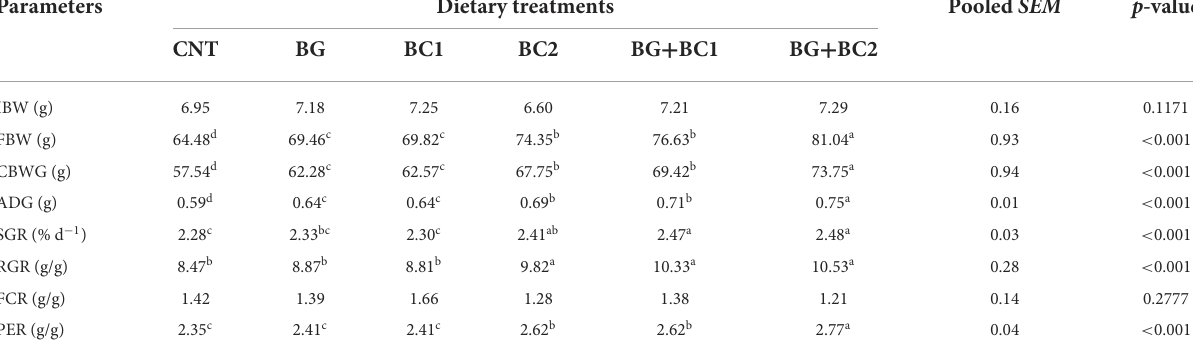
TABLE 3 Effects of dietary supplementation with β -glucan and/or Bacillus coagulans on performance, and efficiency of feed of tilapia fish. Parameters Dietary treatments Pooled SEM p- value